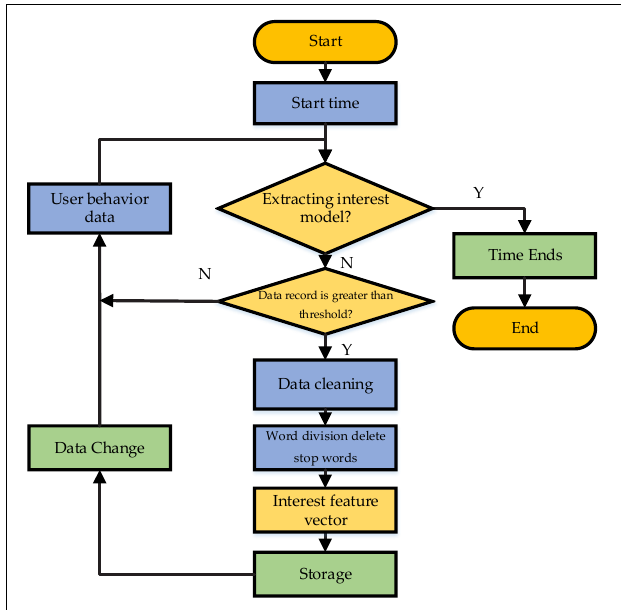
FIGURE 4 | Flowchart of implementing user curiosity model based on Psychology.